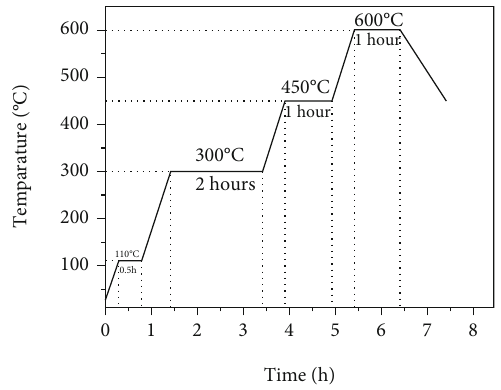
Figure 1: Biochar production process diagram. Table 1: Density and weight loss of each material before and after carbonization.